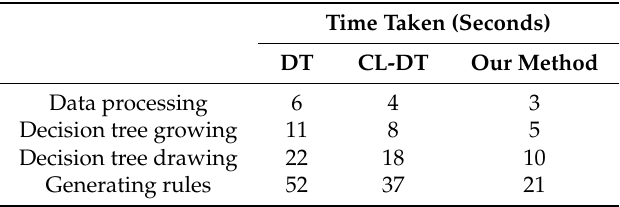
Table 24. Comparison of the computational time of constructing the DT.